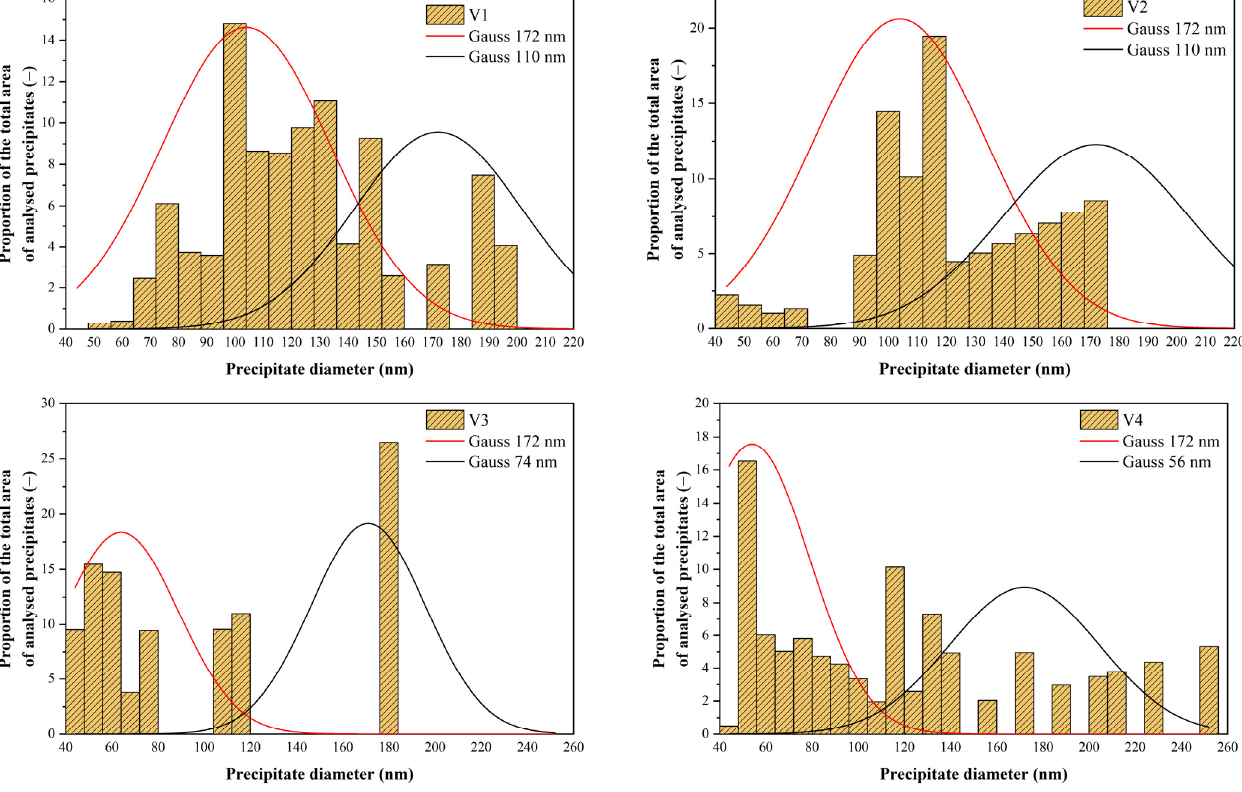
Figure 24. Modified histograms showing the distribution of precipitates above 40 nm in the samples for all variants.